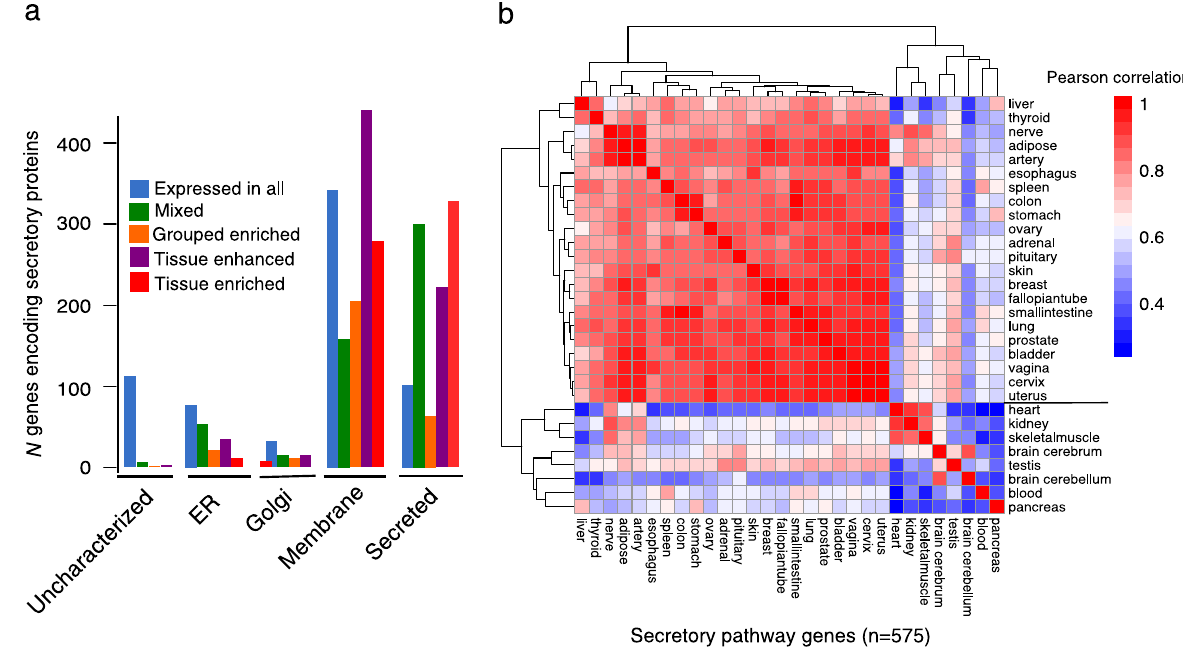
Fig. 2 Expression of the secretory pathway and its clients across human tissues. a The frequency of the different expression categories of human secreted or membrane protein-encoding genes based on GTEx and localization information. Only protein with N-terminal signal peptide is included. Proteins were grouped according to localization. From this set, 503 proteins are localized in the lumen or the membrane of the ER and Golgi which encompass a large part of the secretory pathway components. b Shows the hierarchical clustering of cross-tissue correlation coef fi cients for the expression of secretory pathway genes in the “ tissue-elevated ” and “ expressed in all ” category (see the Methods for de fi nition). The heatmap of the clustering for 30 human tissue pairwise correlation (Pearson correlations) is based on the expression pro fi les of 575 secretory pathway genes. The color code for correlation is depicted next to the